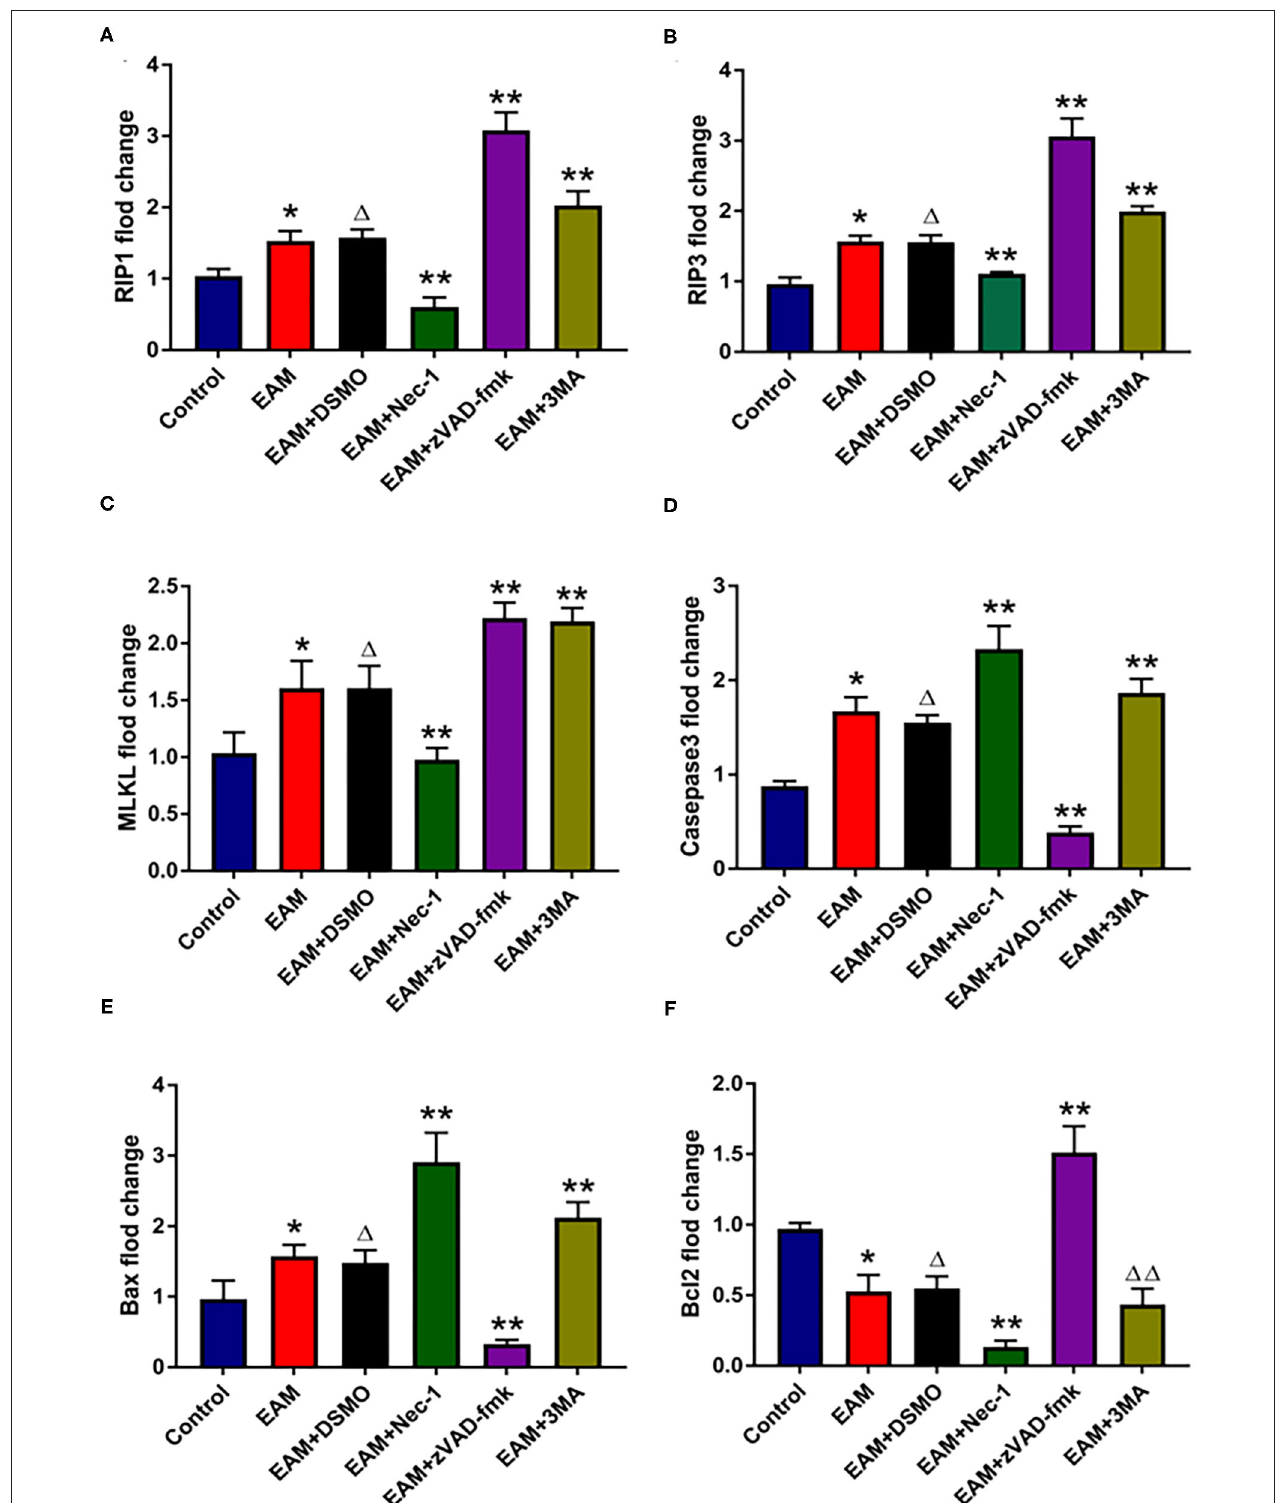
FIGURE 5 | The relative expression of mRNA in myocardial tissue of each group detected by quantitative real-time PCR. (A–C) Real-time PCR analysis of RIP1, RIP3, and MLKL in each group, and inhibited by necrosis inhibitor Nec-1, and 3-MA but increased by zVAD-fmk. For EAM, 3W rats are used. (D–F) Real-time PCR analysis of Caspase 3, Bax, and Bcl2 in each group. The necrosis inhibitor Nec-1 and 3-MA increase the mRNA expression levels of Caspase 3/Bax mRNA in myocardial tissues. * p < 0.05 vs. control group; ** p < 0.01 vs. EAM + DMSO group, 1 p > 0.05 vs. EAM group, 11 p > 0.05 vs. EAM + DMSO group. A Student’s t -test was performed for the control group and the EAM group, one-way analysis of variance (ANOVA) followed by the LSD test; data are presented as mean ± SEM.